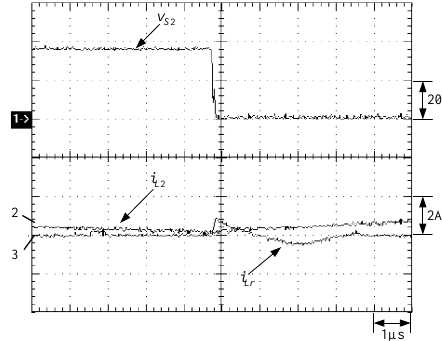
Figure 18. Waveforms pertaining to S 2 , L 2 and L r at the minimum load: (1) v S 2 ; (2) i L 2 ; and (3) i Lr .